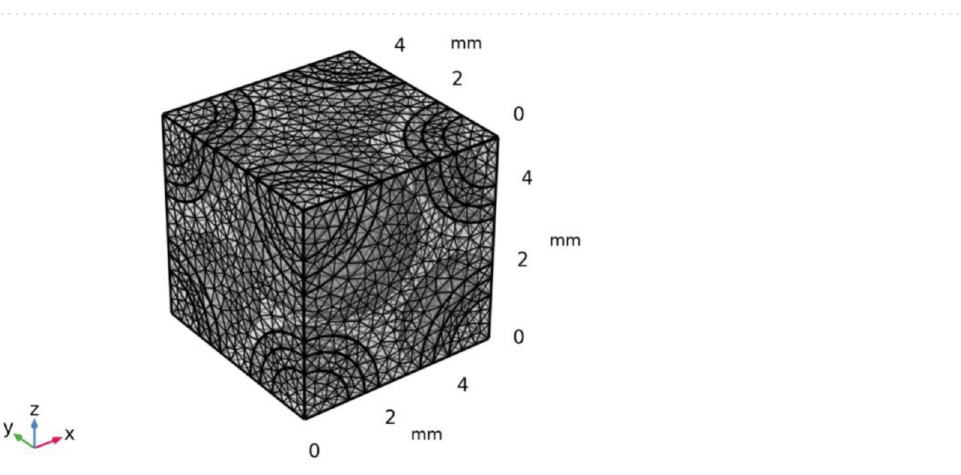
Figure 4. Meshing of a representative volume of green